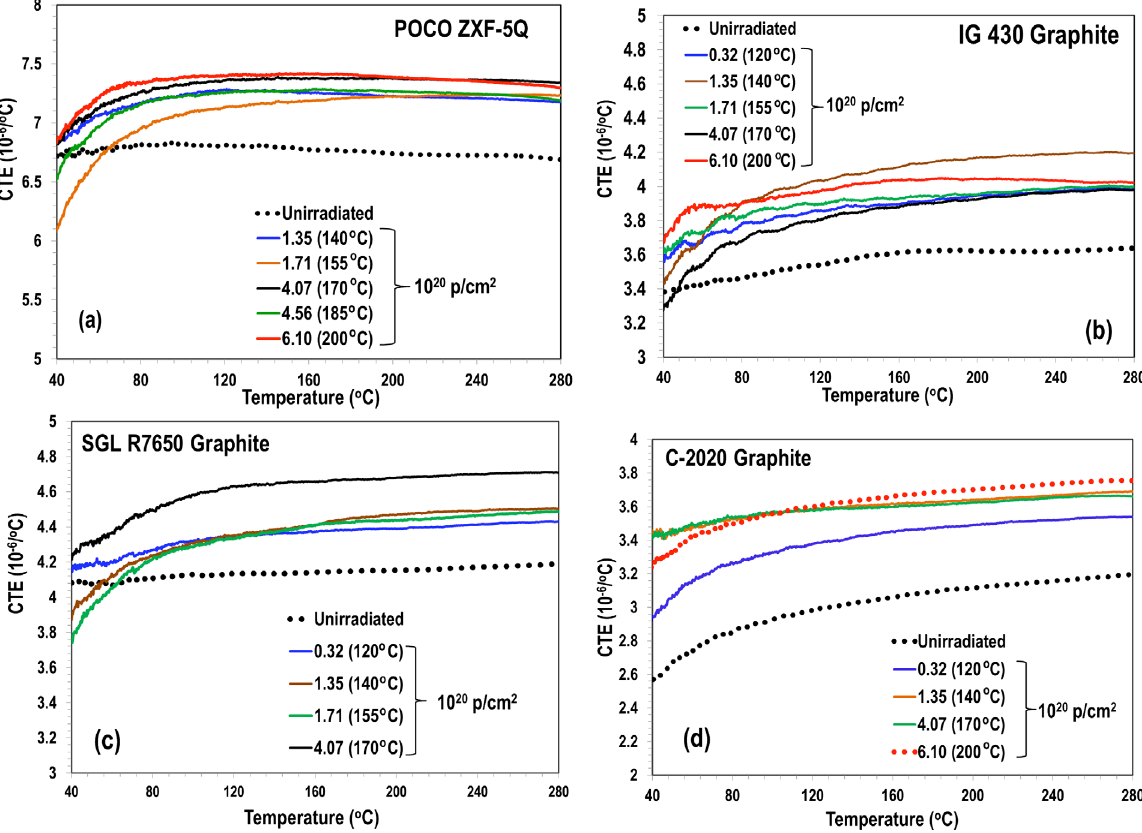
FIG. 11. Proton fluence effects on thermal expansion coefficient for (a) POCO, (b) IG 430, (c) SGL and (d) C-2020 graphite grades. Indicated are fluence followed by corresponding irradiation